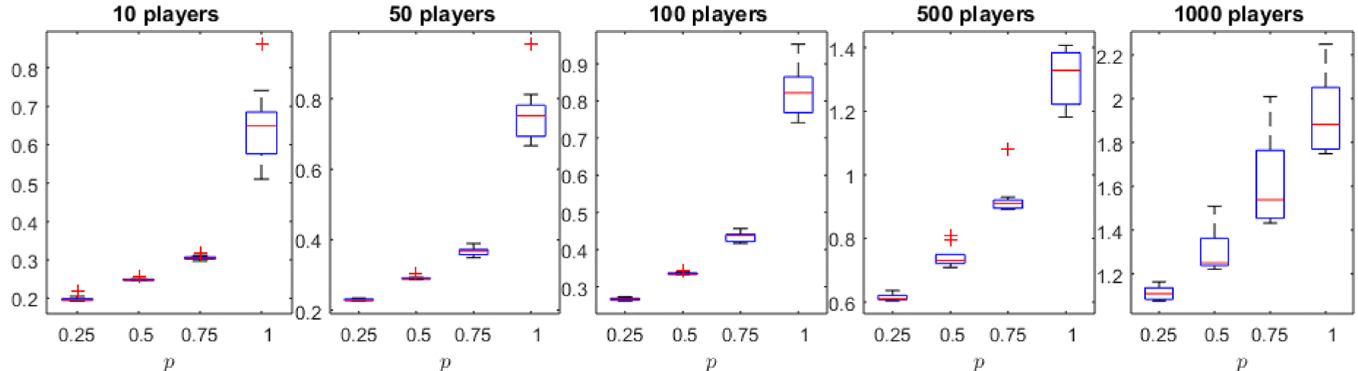
Fig 5. Duration of the runs (in sec.). The null hypothesis that differences betweenmean values are not significantwas rejectedby using a Wilcoxon sum- rank test with a significancelevel of 0.05.